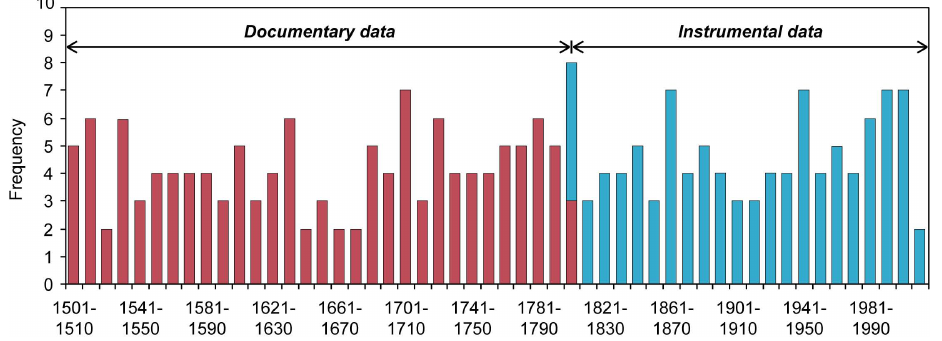
Fig. 7. Decadal frequencies of droughts in the Czech Lands in the 1501–2012 period compiled from documentary data (1501–1804) and the instrumental record